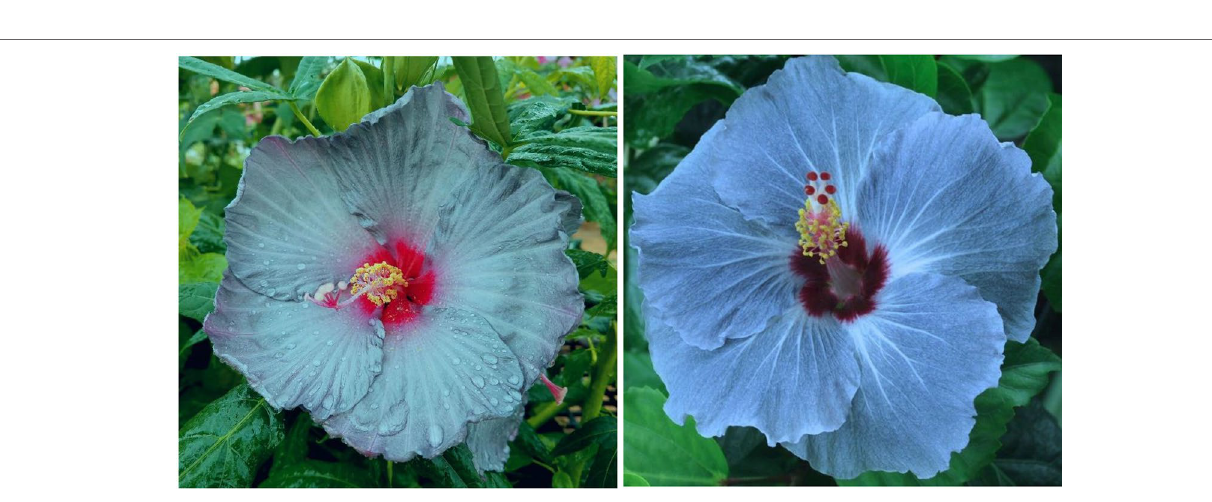
Frontiers in Plant Science |